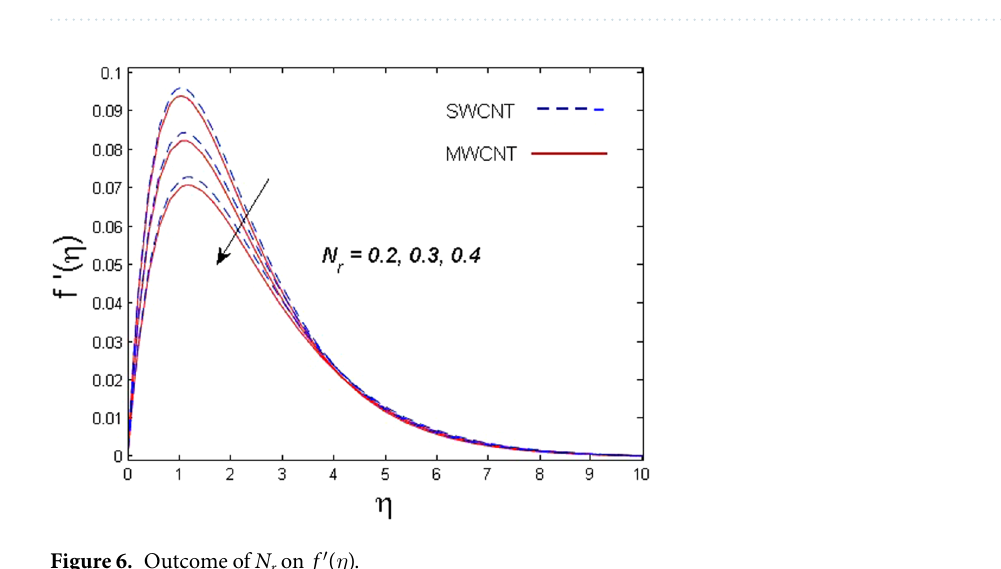
Figure 5. Outcome of v 0 on η ′ f ( ) .